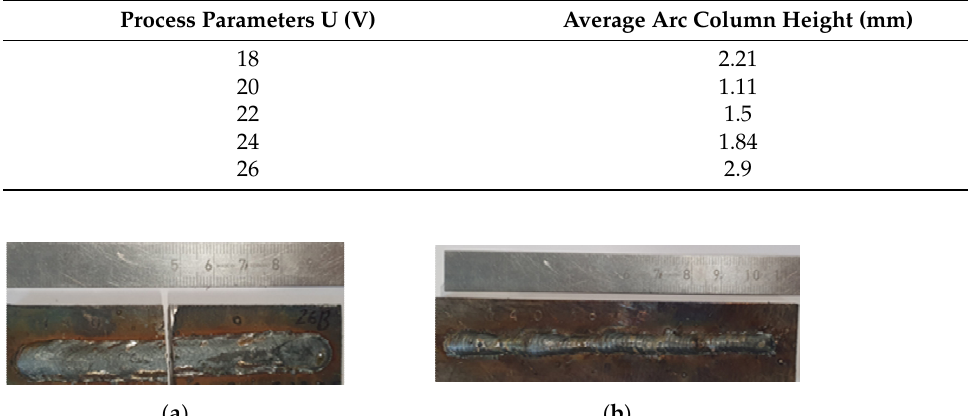
Figure 8. Graphs: ( a )—average arc burning time, ( b )—average short circuit time, ( c )—average peak short circuit current, ( d )—average droplet diameter dependance on the set voltage parameter. Table 3. The welding voltage influence on the height at I = 120 A.